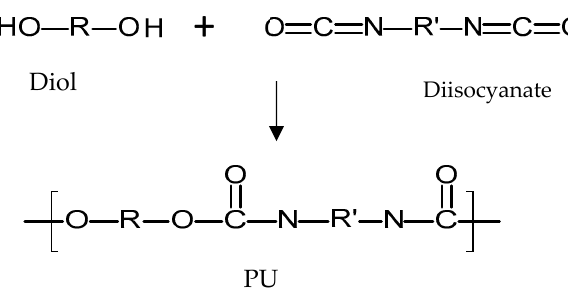
PU Figure 7. An illustration of the chemical structure of poly(urethane) Figure 7. An illustration of the chemical structure of poly(urethane) (PU).